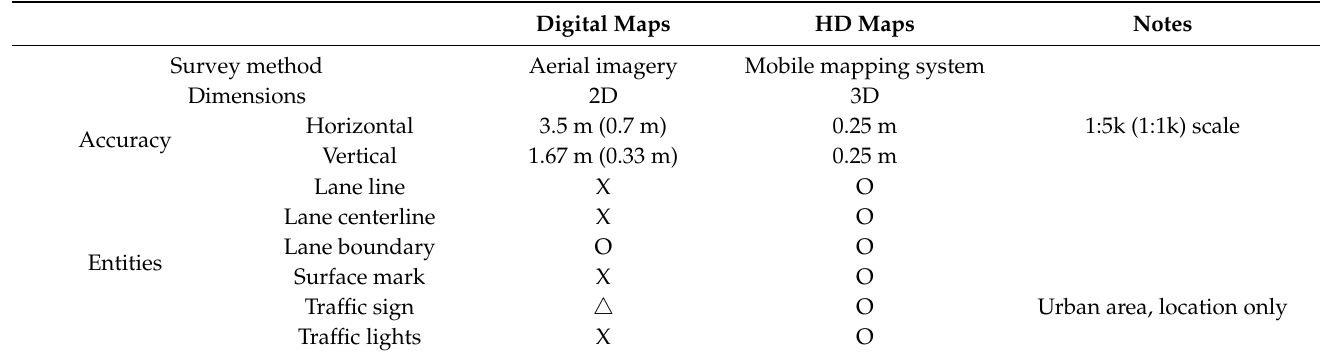
Figure 1. Shape comparison of ( a ) digital and ( b ) HD maps. J denotes a junction. Table 2. Comparison between digital and HD maps (adapted from [2]).